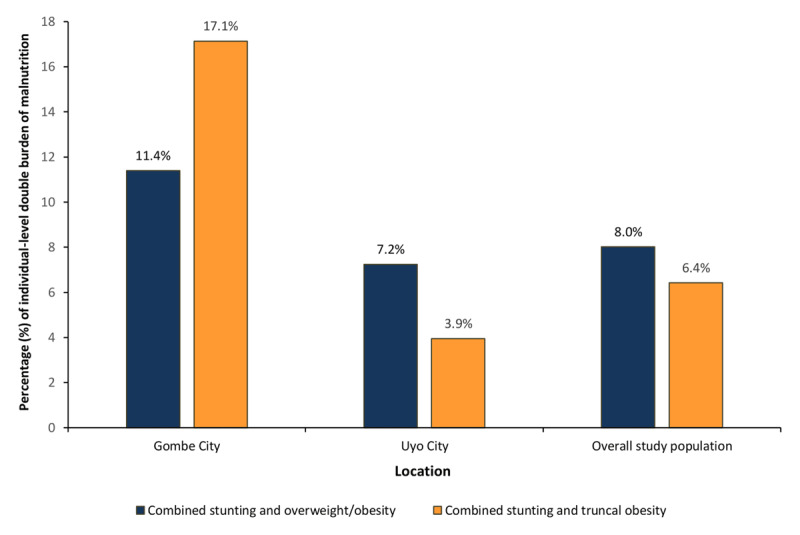
The prevalence rate of individual-level double burden malnutrition among adolescents in Gombe, Uyo and the overall study population. Note: This graph shows the proportion of adolescents who were either concurrently stunted (HAZ < –2SD) and overweight/obese (BAZ > 1SD) or Stunted (HAZ < –2SD) and had truncal obesity (WHtR ≥ 0.5).